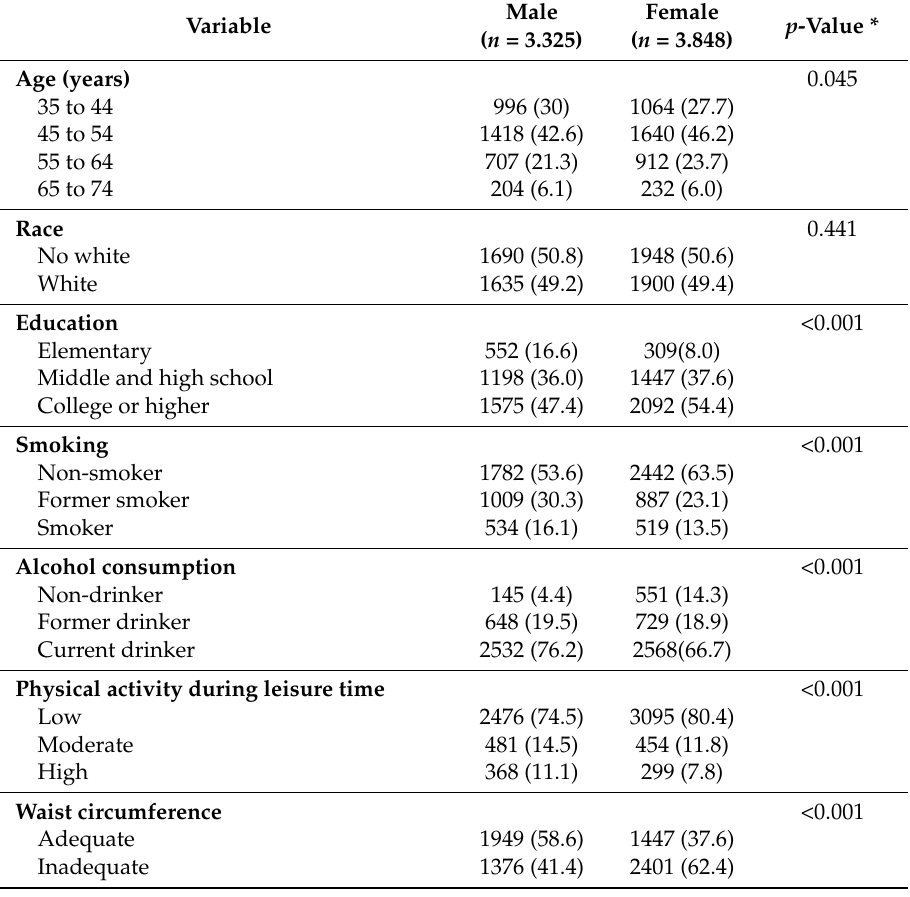
Table 1. Baseline characteristics of participants according to sex. ELSA-Brasil, 2008–2010. Variable